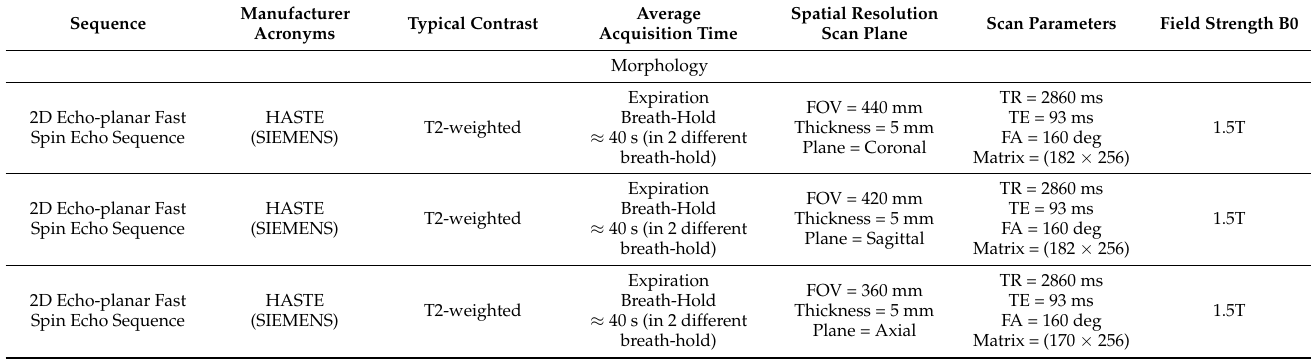
Table 3. Proposed MRI protocol for patients with malignant pleural mesothelioma. TSE: turbo spin echo; HASTE: half-Fourier acquired single shot turbo spin-echo; VIBE: Volumetric interpolated breath-hold examination; DWI: diffusion weighted imaging; SPAIR: spectral attenuated inversion recovery; FOV: field of view; TR: repetition time; TE: echo time; FA: flip